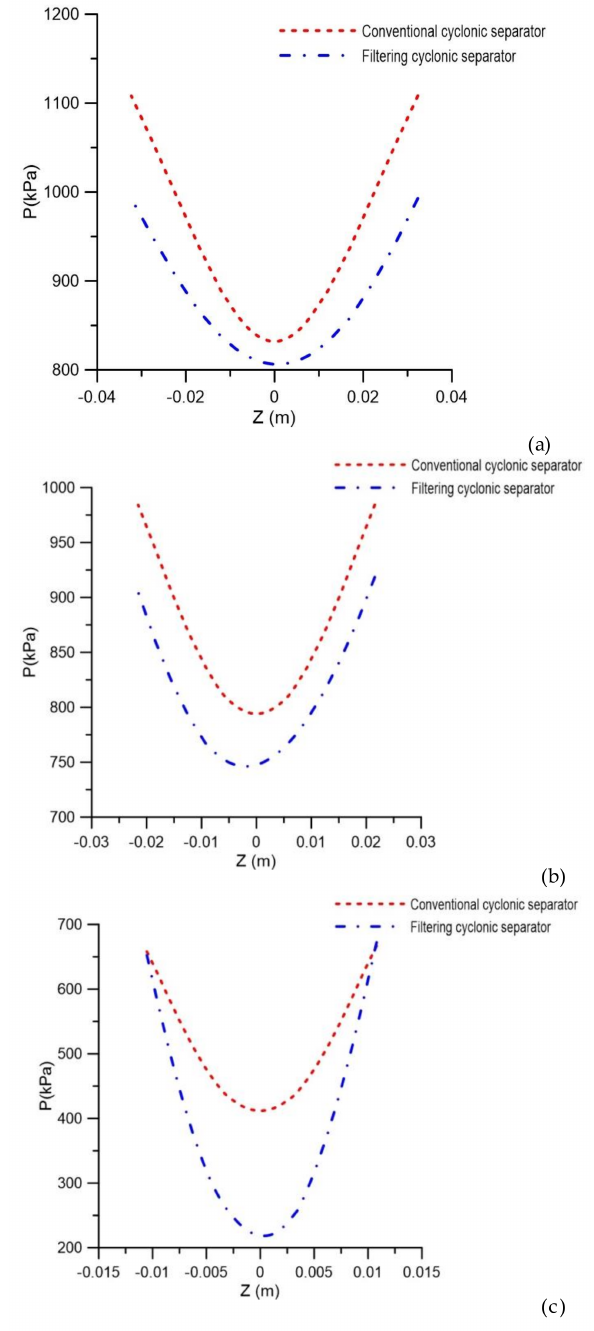
Figure 6. Pressure profile in conventional and filtering hydrocyclones at positions ( a ) y = 0.15 m, ( b ) y = 0.45 m and ( c ) y = 0.75